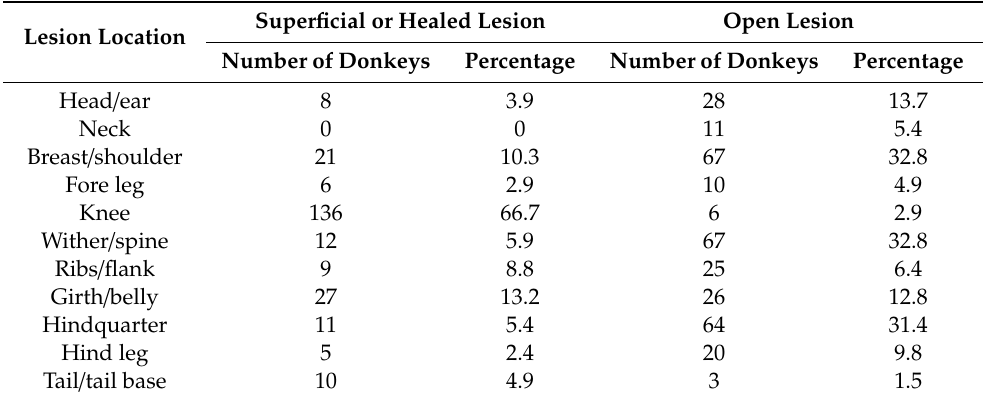
Table4. Numberof donkeyssu ff eringfromsuperficial andopenlesions. Deep lesionswerenotreported. Superficial or Healed Lesion Open Lesion Lesion Location Number of Donkeys Percentage Number of Donkeys Percentage Head /